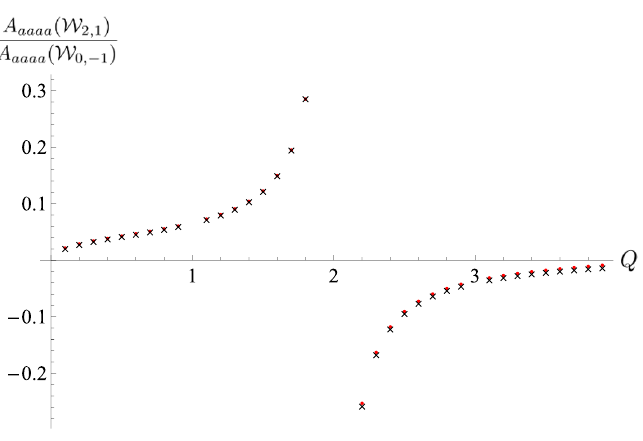
Figure 20 . The amplitude A aaaa ( W 2 , 1 ) normalized with the leading amplitude A aaaa ( W 0 , − 1 ) in P aaaa . Comparison of the lattice results (indicated with × ) and bootstrap results (indicated with • ).